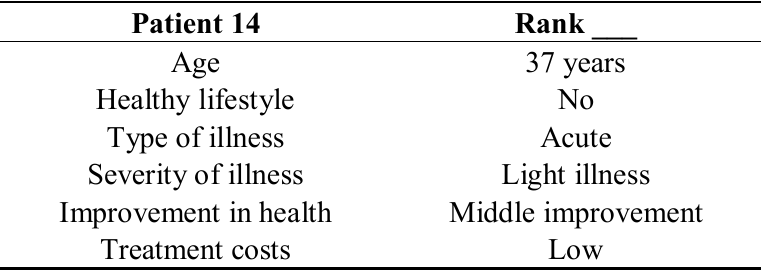
Table 3. Hypothetical patient card for the ranking